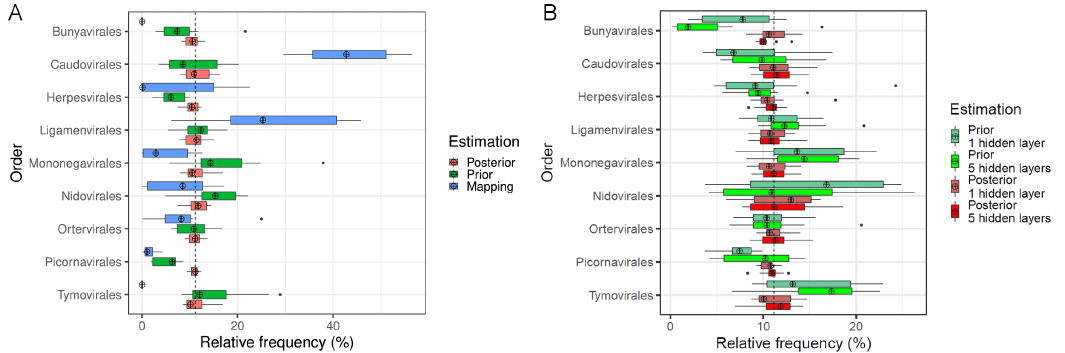
Figure 4. Comparison of estimated taxa frequencies. Distribution of taxa frequencies summarized from 10 simulations runs. ( A ): comparison of estimation by the mapping approach, ANN (1 hidden layer) based prior and posterior estimation of taxa frequencies show that posterior estimations are much closer to the true frequencies of 11% (dashed line) per order in terms of the mean absolute deviation (MAD) and thus more precise in relation to the prior and mapping based estimations. ( B ): comparison of prior and posterior estimations when using an ANN with either 1 or 5 hidden